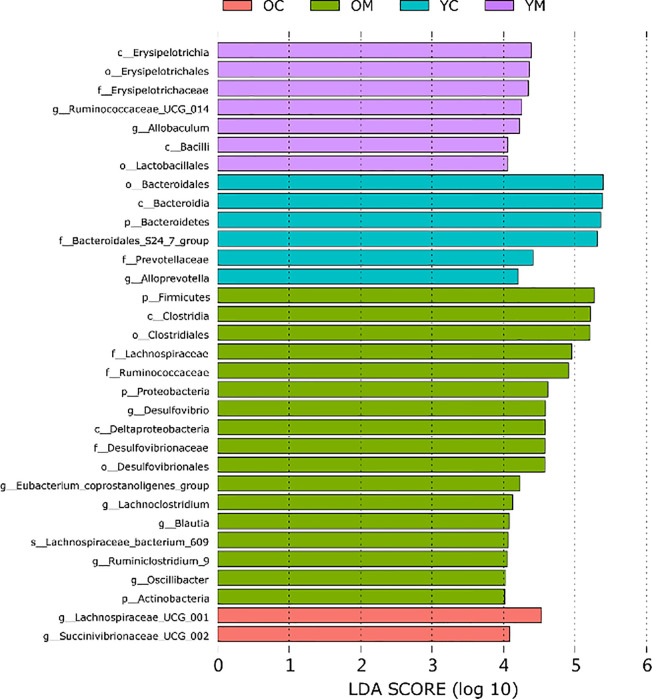
Differently enriched bacterial taxa among four groups which is determined using LEfSe algorithm, n=4 mice per group.